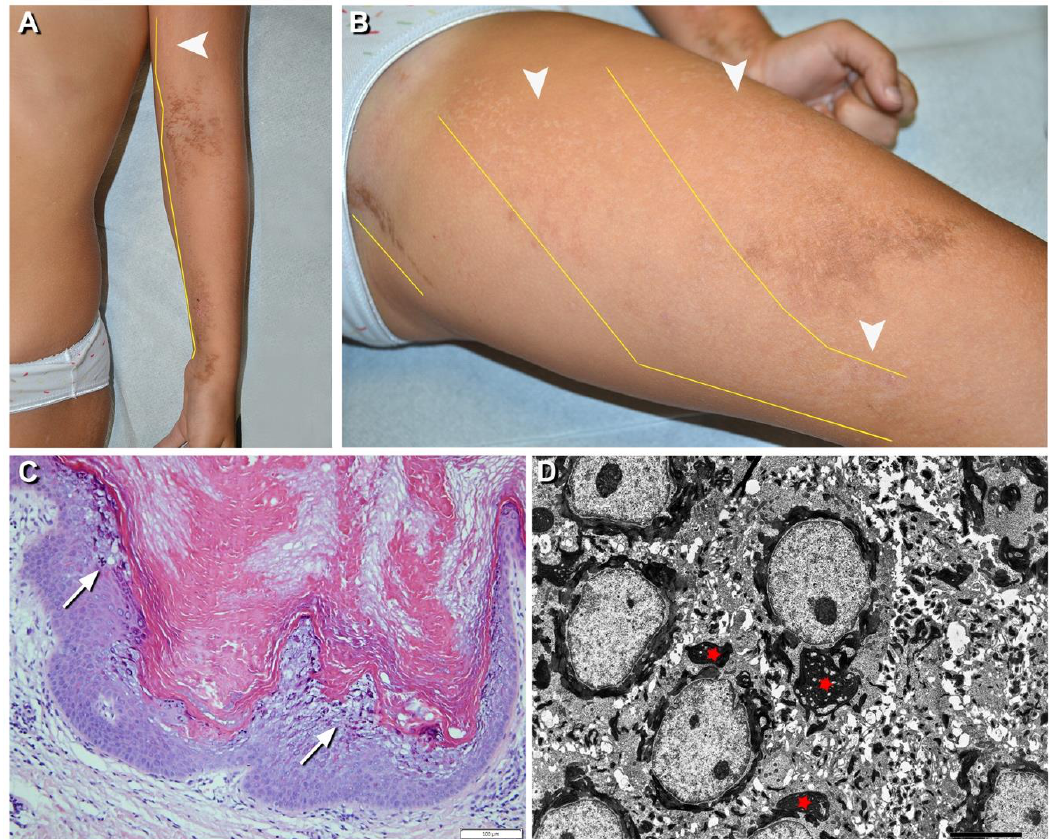
Figure 3. Clinical, histopathological, and ultrastructural findings in epidermolytic nevus (EN) due to KRT10 somatic mutation. Hypopigmented (arrowheads) and brownish hyperkeratotic linear lesions following a blaschkoid distribution (yellow lines) on the left upper and lower limbs ( A , B ) of a 7-year-old girl ( n . 17 of Table 1). Focal vacuolar degeneration (arrows) of suprabasal epidermal layers with hypergranulosis and compact hyperkeratosis. Numerous eosinophilic cytoplasmic inclusions in suprabasal epidermal layers are also visible ( C ) and correspond to perinuclear tonofilament aggregation and clumping (asterisks) visualized by ultrastructural examination ( D ). Bar: 100 µm in ( C ) and 5.0 µm in ( D ).